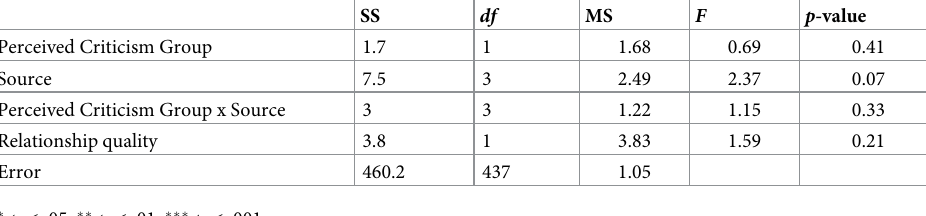
Table 2. Analysis of variance table for levels of hurt. Perceived Criticism Group 1.7 Source Perceived Criticism Group x Source